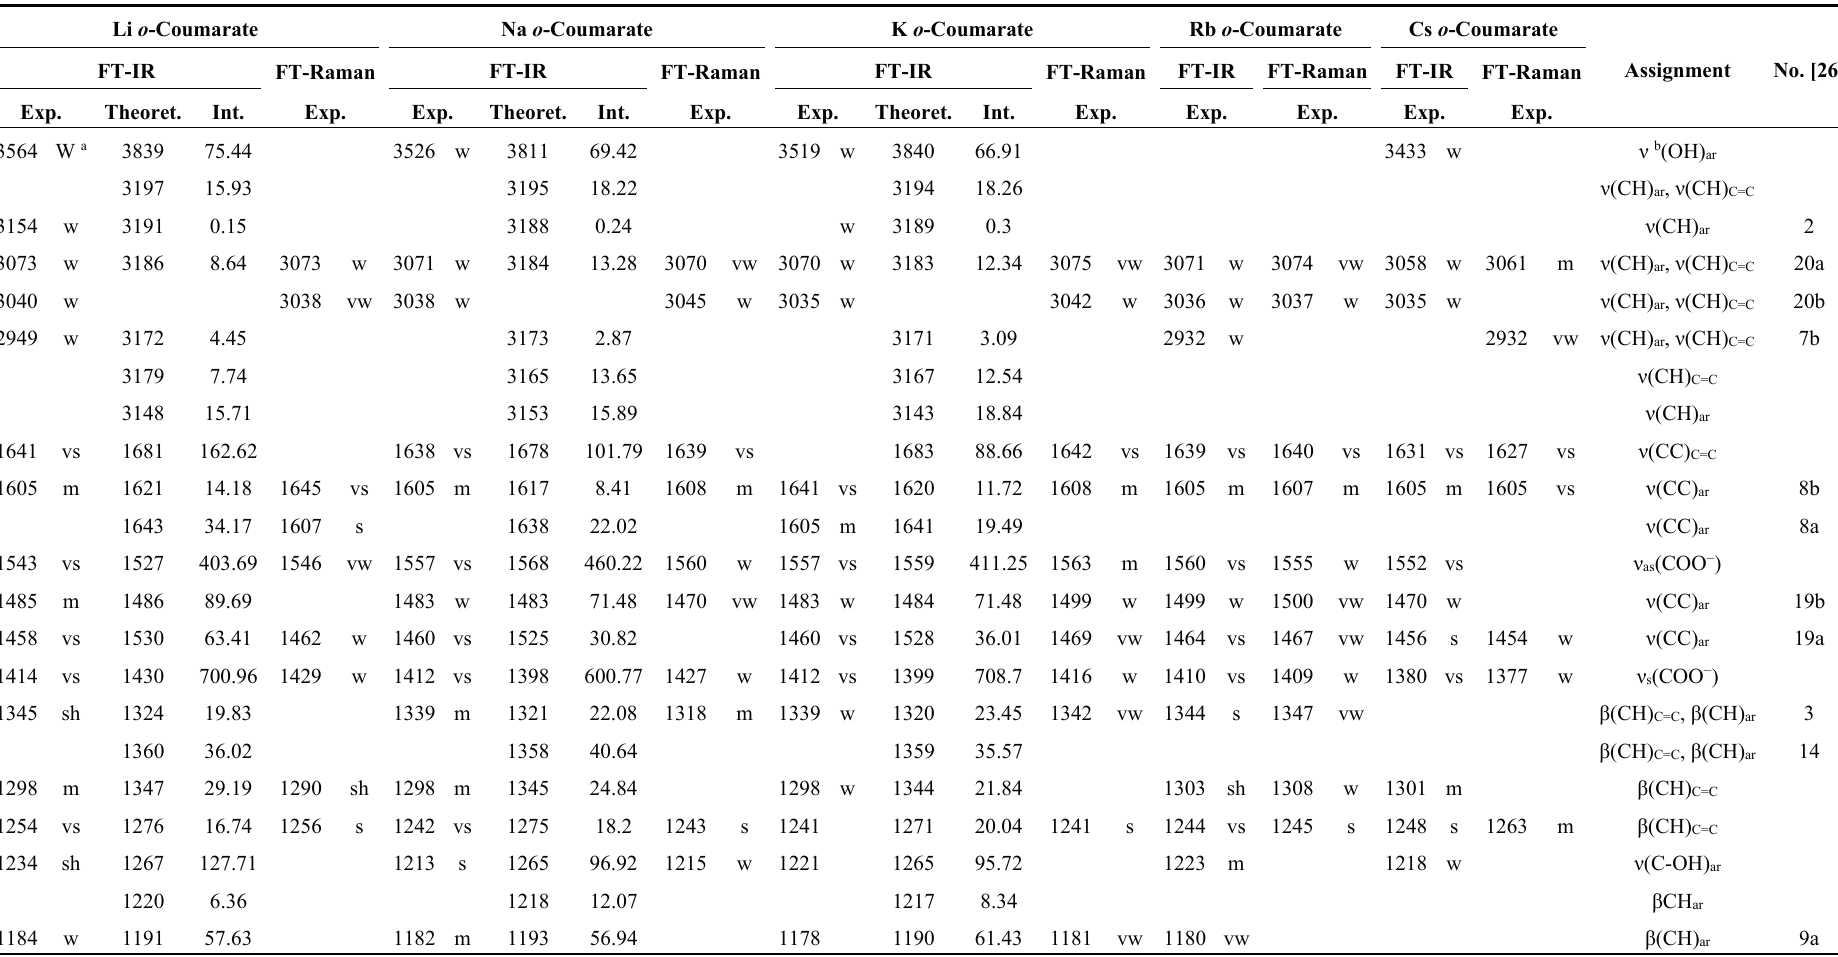
Assignment FT-Raman FT-IR FT-Raman FT-IR FT-Raman FT-IR FT-IR FT-Raman